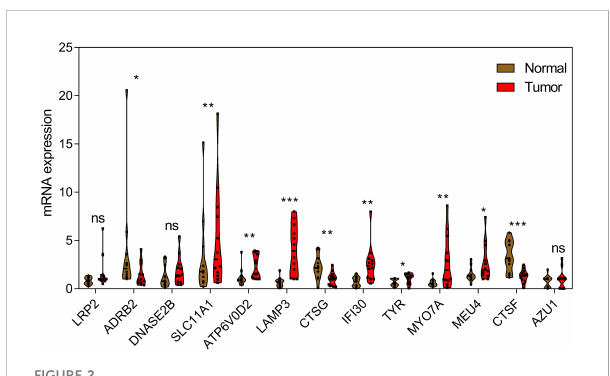
FIGURE 2 qRT-PCR analysis of 13 LYAGs in clinical samples in GC and corresponding adjacent normal tissues. *p < 0.05, **p < 0.01, ***p < 0.001. ns, no signi fi